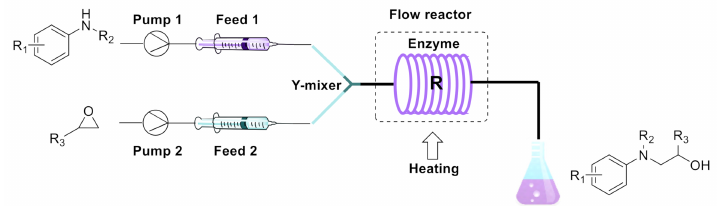
Figure 7. Equipment for the enzymatic synthesis of β -amino alcohols under continuous-flow